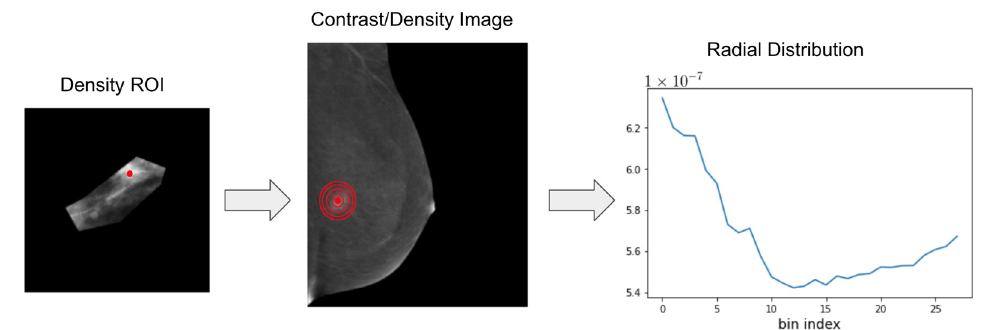
Figure 3. Creating histograms of radial distribution of density and contrast. Concentric bands (red circles) were automatically defined around the center of mass (red dot) of each finding and intensity values from each band were summed and normalized to create a histogram representing the distribution of density or contrast as a function of distance from the center of mass. The rightmost plot shows the histogram corresponding with the mammogram shown in the middle. Here, the x-axis represents the bin indexes corresponding with the concentric bands and the y-axis represents the normalized total mass (contrast/density) present in the